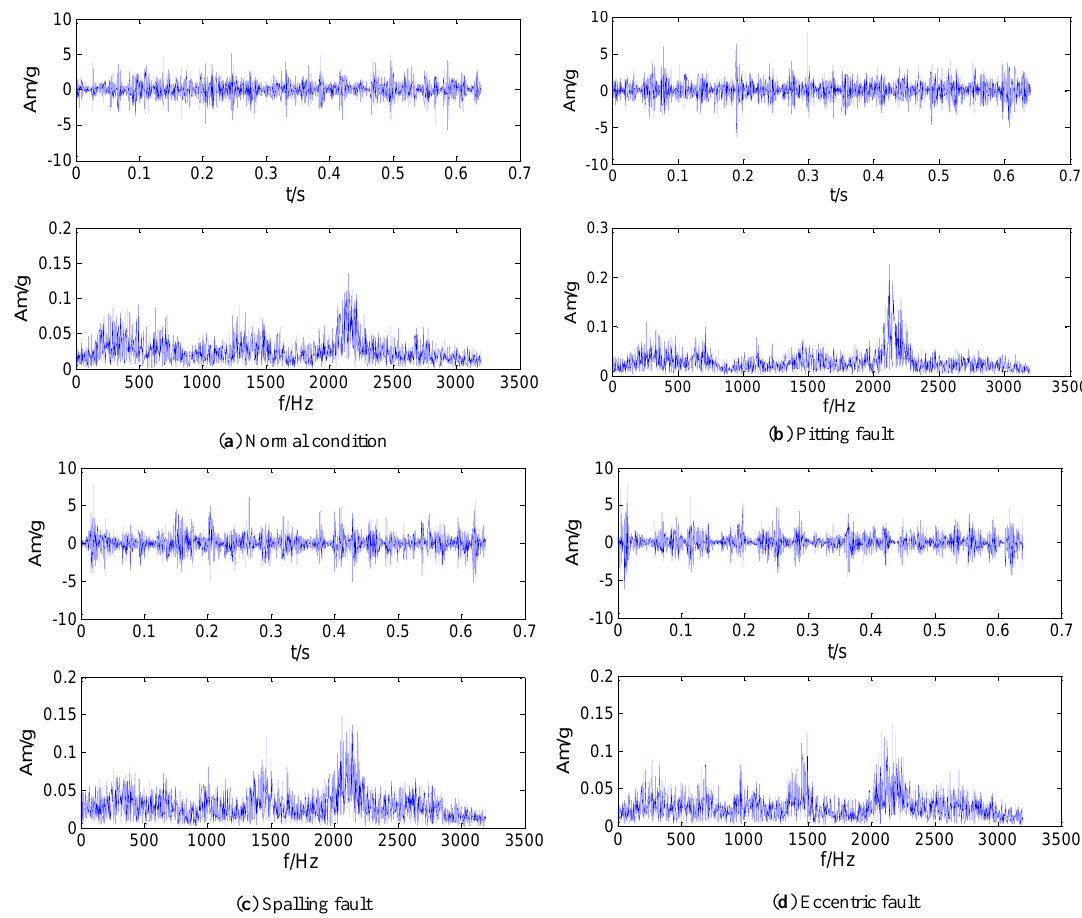
Figure 9. Vibration signals of time- and frequency